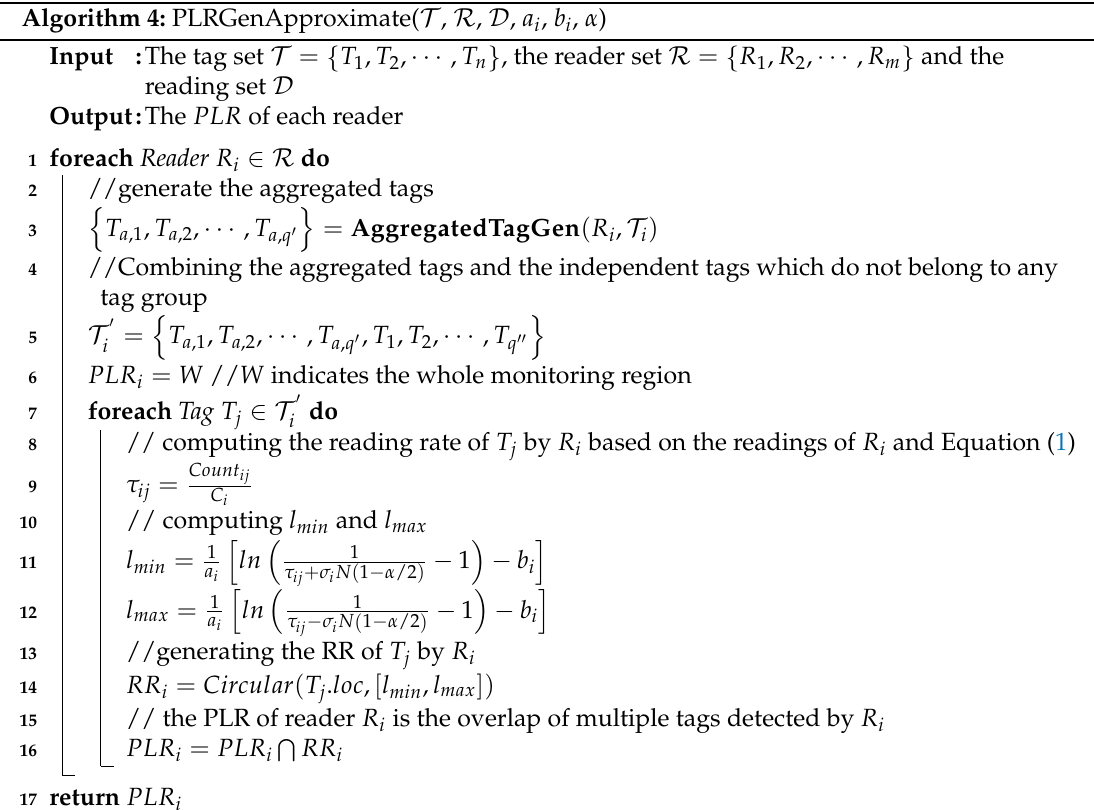
Algorithm 4: PLRGenApproximate( T , R , D , a i , b i , α